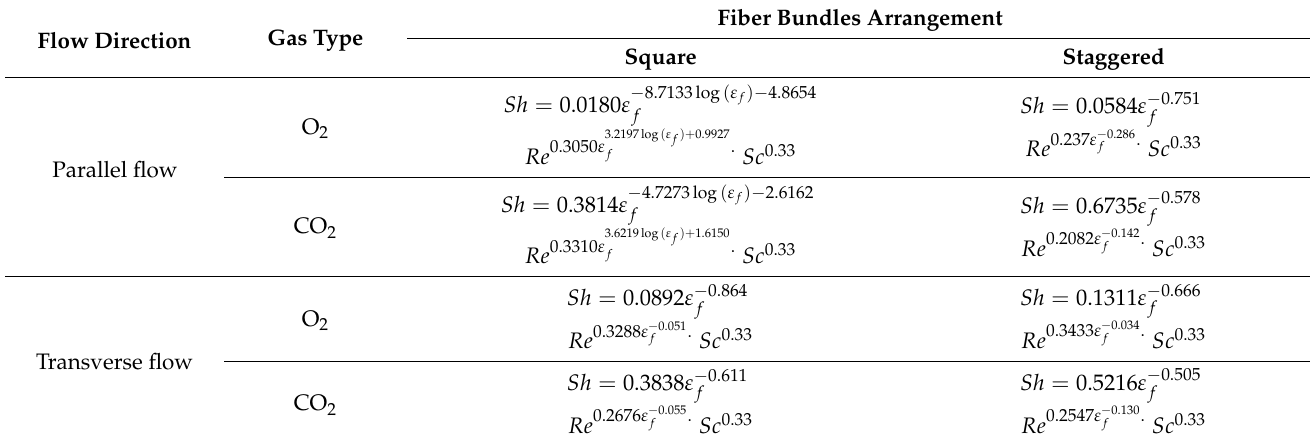
Table 3. Generalized mass transfer correlations with parallel and transverse flow for hollow fiber blood oxygenator in square or staggered arrangement (with ε f is the void fraction of the bundle of hollow fibers) (equations obtained from